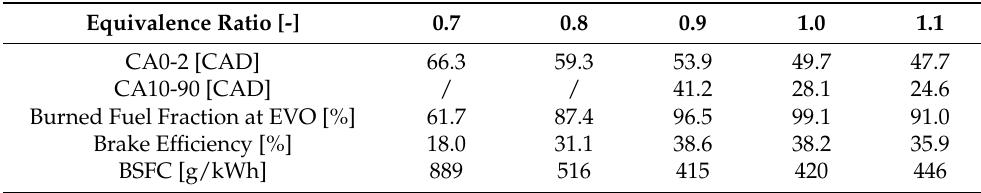
Figure 6. In-cylinder pressure ( left ) and brake power ( right ) for different equivalence ratios; 1500 rpm, SA = 69 °bTDC, WOT, no boost. Table 7. Combustion characteristics and engine performance; 1500 rpm, SA = 69 °bTDC, WOT, no boost.